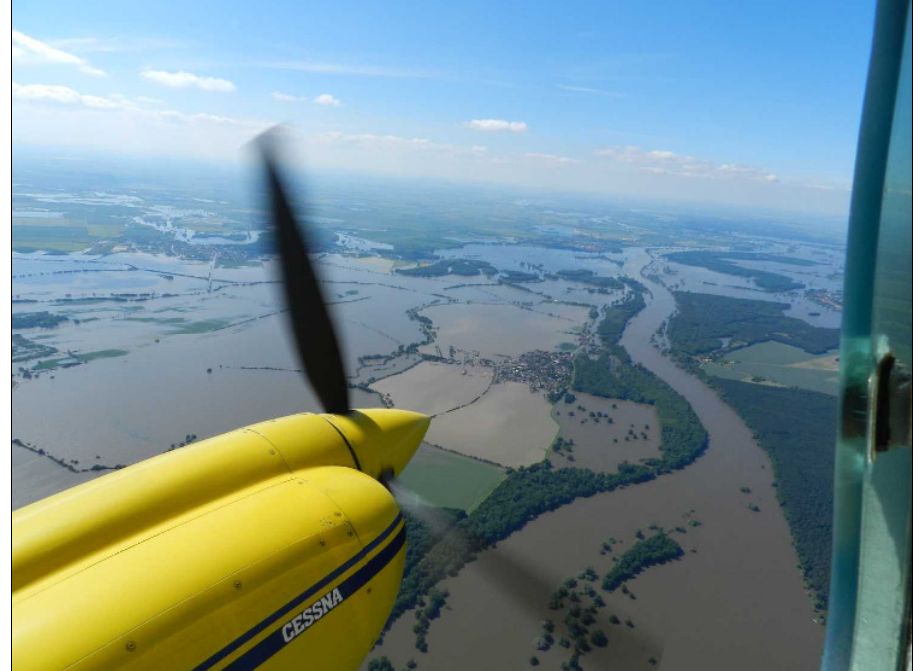
Fig 3: Flooding of river Elbe (taken from Hansa Luftbild airplane) Hansa Luftbild received the demanding order to record this damage event by means of aerial